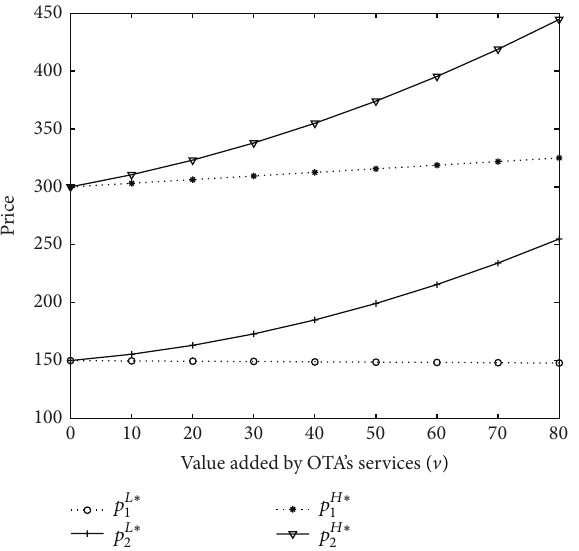
Figure 2: Equilibrium prices in the integrated system.